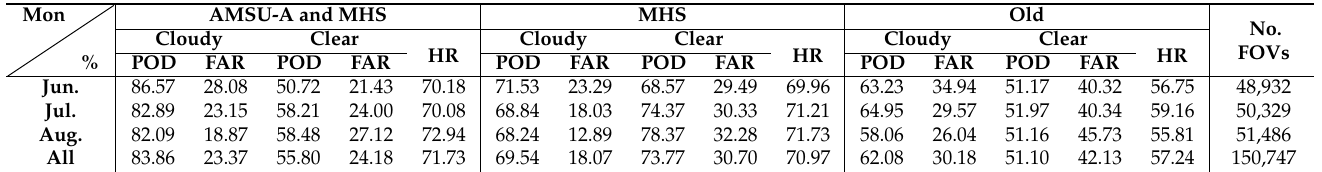
( c ) No. FOVsCloudy Clear